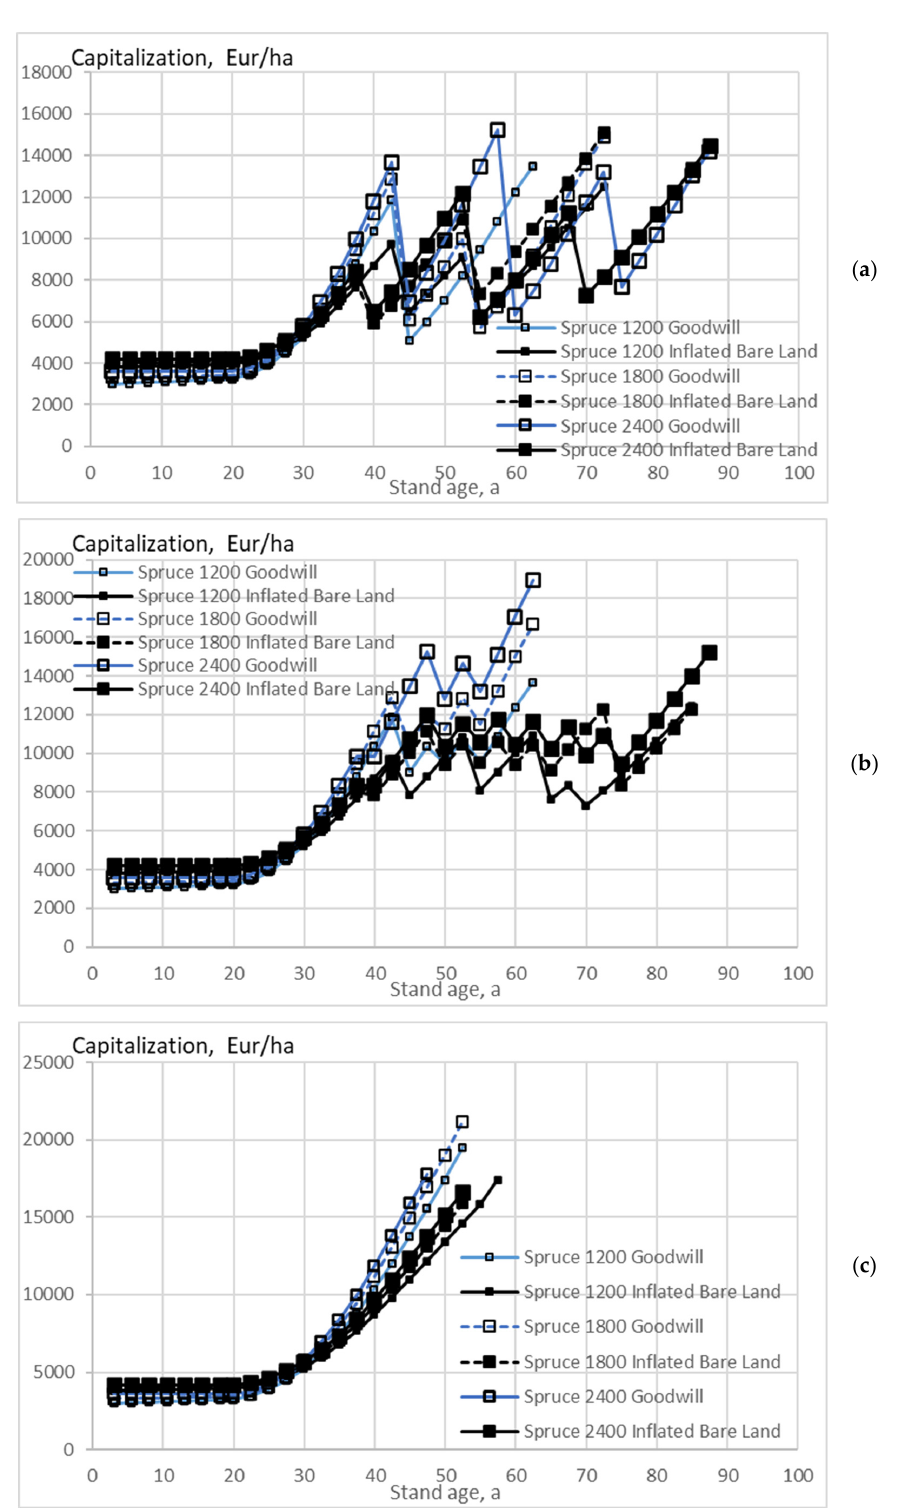
Figure 9. Capitalization on spruce stands of different initial sapling densities, as a function of stand age, when the growth model is applied as early as applicable, without any thinning restriction ( a ), in good-quality trees of at least 238 mm of diameter only removed in thinning ( b ), and without any commercial thinning ( c ). Inflated capitalization is introduced either as proportional goodwill or as inflated bare land